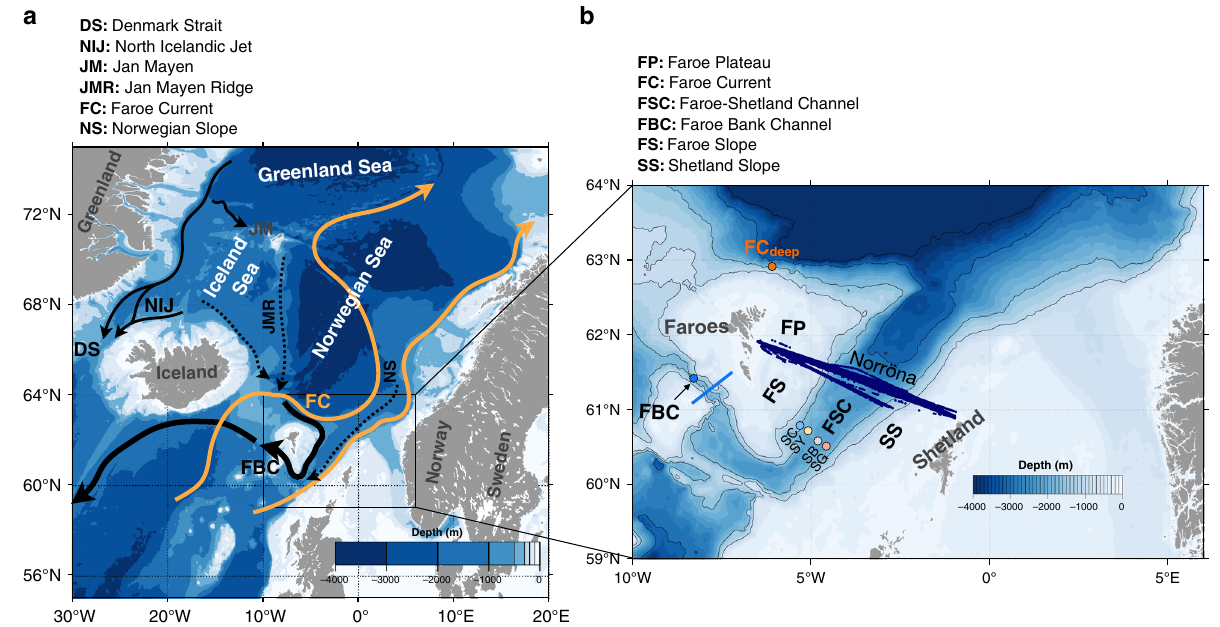
Fig. 1 Nordic Seas overturning circulation pathways. a Bathymetric chart (shading; m) with the main upper-ocean (orange) and traditional deep (black) branches of the overturning circulation in the Nordic Seas. The dashed lines are deep branches suggested by earlier modeling studies to feed the Faroe Bank Channel 13,14 . b A zoomed map of the study region including locations of the multiple observational platforms used in this work. The circles refer to the deep Acoustic Doppler Current Pro fi ler (ADCP) moorings (see Methods section). The light blue section is the hydrographic transect in the Faroe Bank Channel. The dark blue dots across the Faroe-Shetland Channel (FSC) indicate sites of velocity pro fi les from the vessel-mounted ADCP onboard MS Norröna. The black contours depict the 500, 800, 1500, and 2000 m